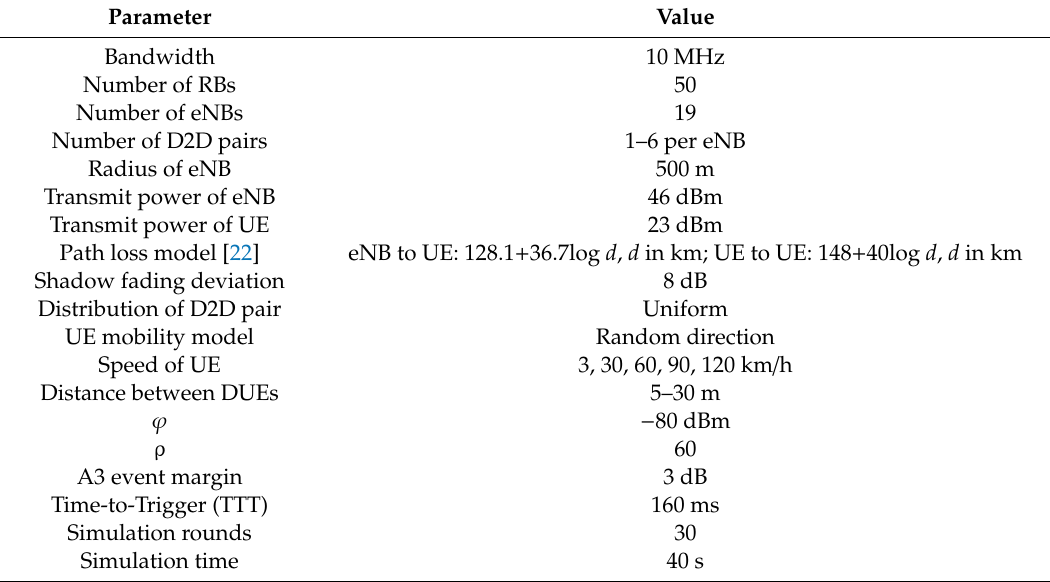
Table 1. Simulation